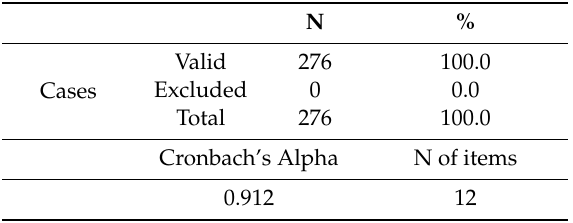
Table 4. Reliability Analysis of questionnaire on the risk